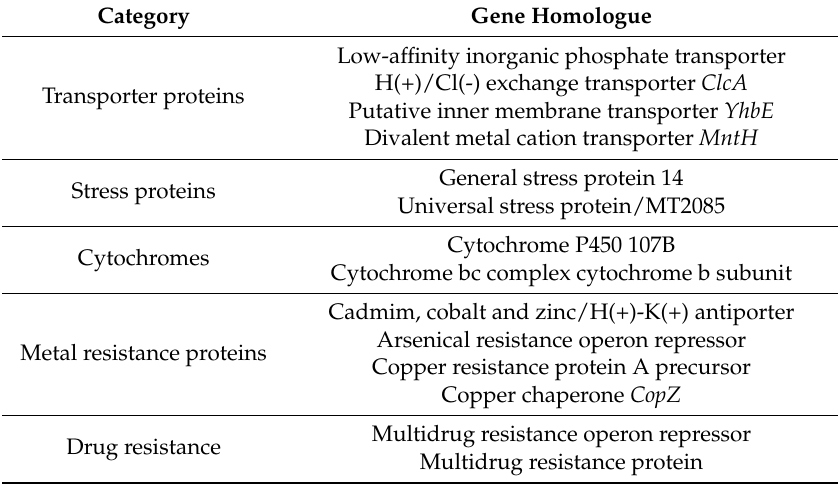
Figure 7. Shown are the whole genome-based Venn diagrams generated between Arthrobacter sp. SRS-W-1-2016 with its closest functional relatives. Venn diagram sectors belong to 1, Phenarthrobacter aurescens TC1; 2, Arthrobacter cupressi strain CGMCC; 3, Arthrobacter globiformis strain NBRC12137; 4, Arthrobacter sp. SRS-W-1-2016; and 5, Pseudoarthrobacter phenanthrenivorans strain Sphe3. The number of singleton genes appear in red, green, yellow, blue, and white areas for strains 1–5 listed above, respectively -along with their core genomes (centered gray area). Table 2. Shown are PROKKA-annotated gene homologues that likely perform a biodegradative or metal resistance function in Arthrobacter sp. strain SRS-W-1-2016. The analysis was conducted by manually querying the set of 1159 genes that were identified only in Arthrobacter sp. strain SRS-W-1-2016, for desired bioremediation functions.